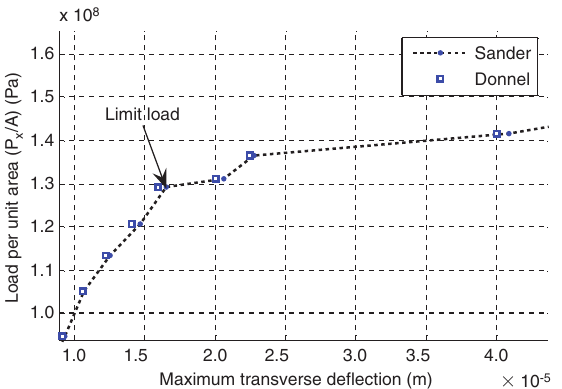
Figure A-3 Neighborhood of limit load for uniform-thickness curved plate with ply confi guration [0